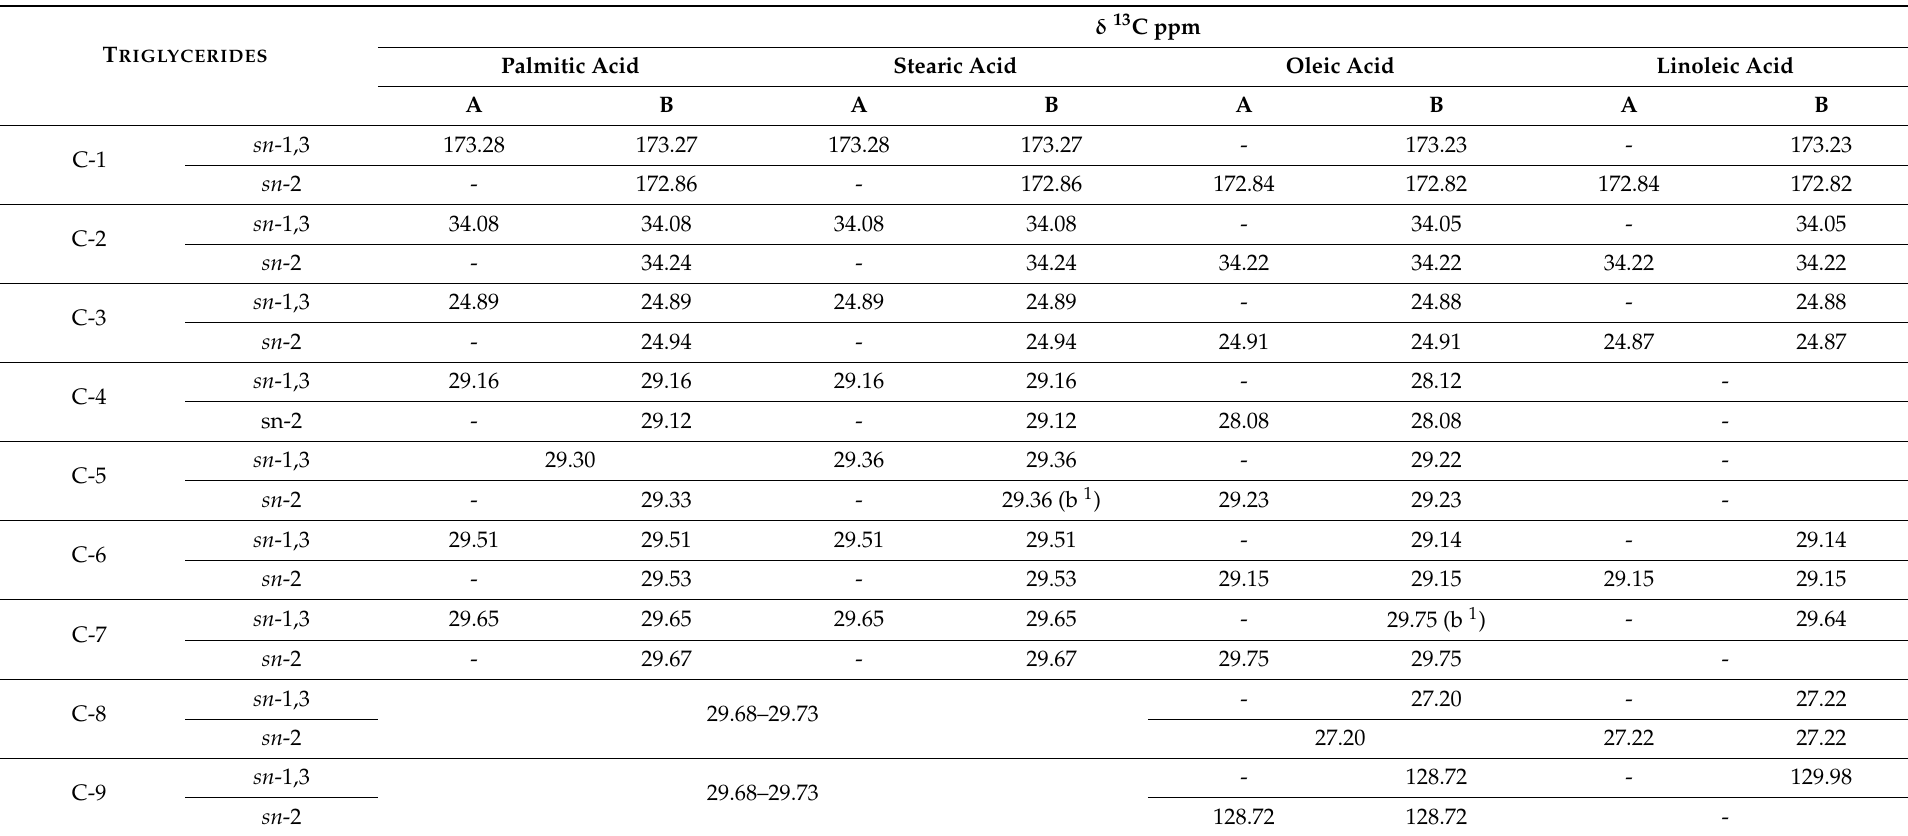
Table 3. 13 C NMR (125 MHz, 298 K, in CDCl 3 ) assignment for natural (sample A) and modified (sample B) CB. The values reported in the table show clearly how the chemical shifts ( δ 13 C, ppm) for the FAs in CB depend often significantly on the position of the acyl chain on the glycerol scaffold (indicated as sn -1,2,3 as specified in the Introduction). The numbering for the carbon nuclei is explained in Figure